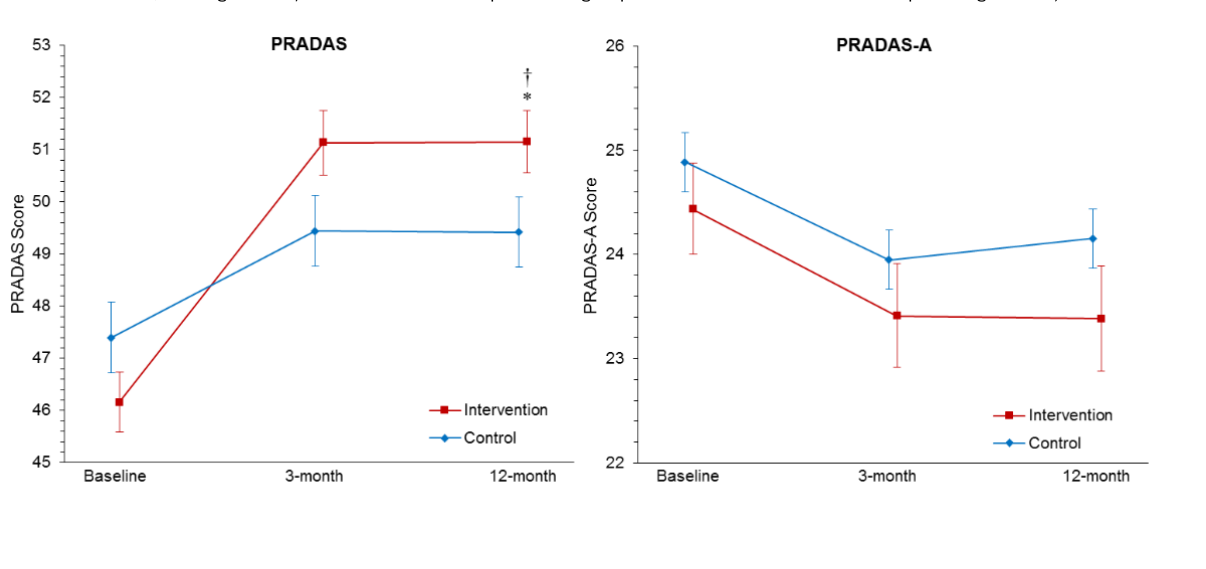
Figure 2. Estimated marginal means for Parenting to Reduce Adolescent Depression and Anxiety Scale (PRADAS) and PRADAS—Adolescent (PRADAS-A) Report scores at baseline, postintervention (3-months postbaseline), and 12-month follow-up, estimated under the group × measurement-occasion mixed model. Error bars represent SEs. Higher scores on the PRADAS and PRADAS—Adolescent Report indicate greater concordance with the parenting guidelines (ie, more protective parenting factors and fewer parenting risk factors). Planned contrast of interaction (baseline to 12 months) was significant, P <.001. Pairwise comparison of group difference at 12-month follow-up was significant, P =.04.